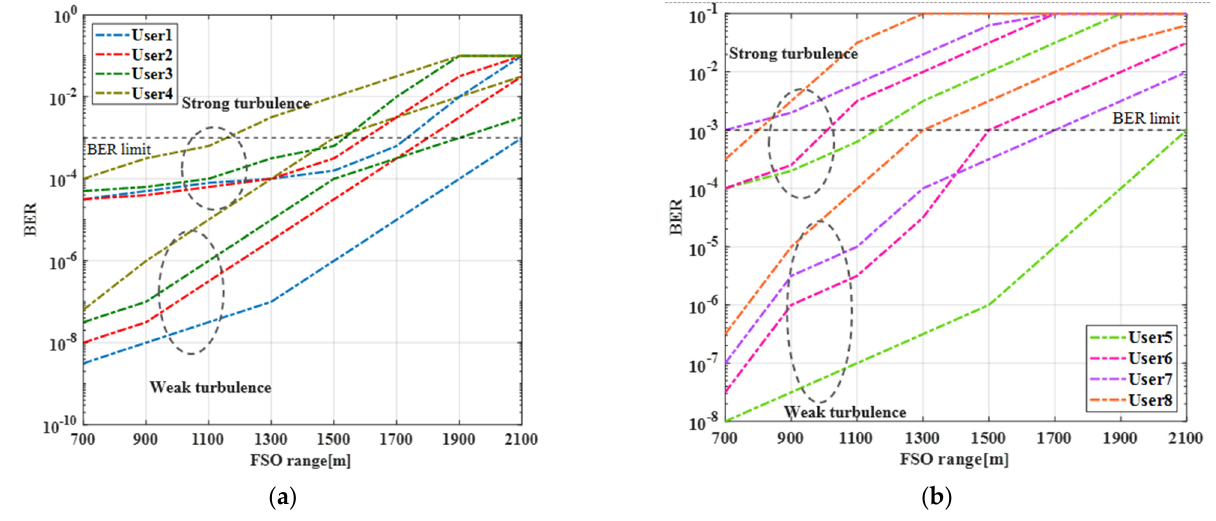
Figure 5. Measured BER under gamma-gamma turbulence modeling. ( a ) Users 1 to 4 operating at Donut mode 0, ( b ) users 5 to 8 operating at Donut mode 1.